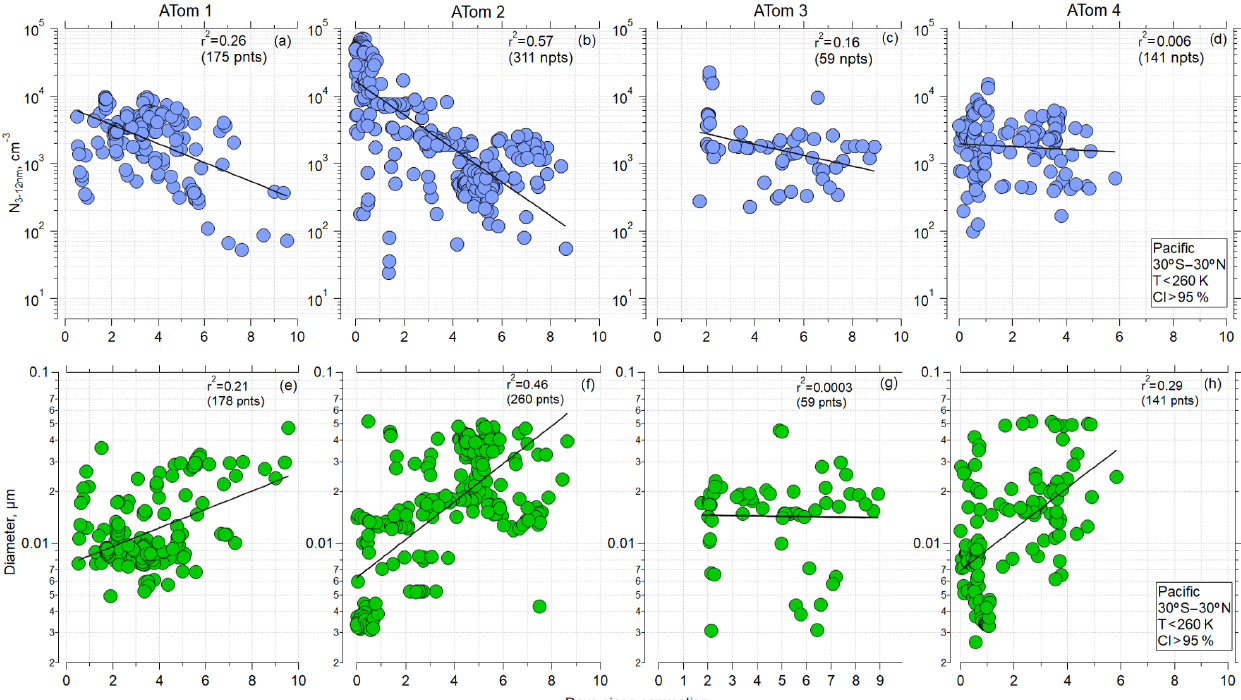
Figure 4. (a–d) Concentration of nucleation-mode particles as a function of time since convective influence for ATom missions 1–4, over Pacific (30 ◦ S–30 ◦ N), T < 260K, and probability of convective influence > 95%, respectively. (e–h) Modal diameter of particles with D p < 0 . 06µm as a function of time since convective influence (30 ◦ S–30 ◦ N) for ATom missions 1–4, respectively. Black line, used to guide the eye, represents the linear regression fitted to log- y values. A corresponding Pearson correlation coefficient r 2 is indicated.